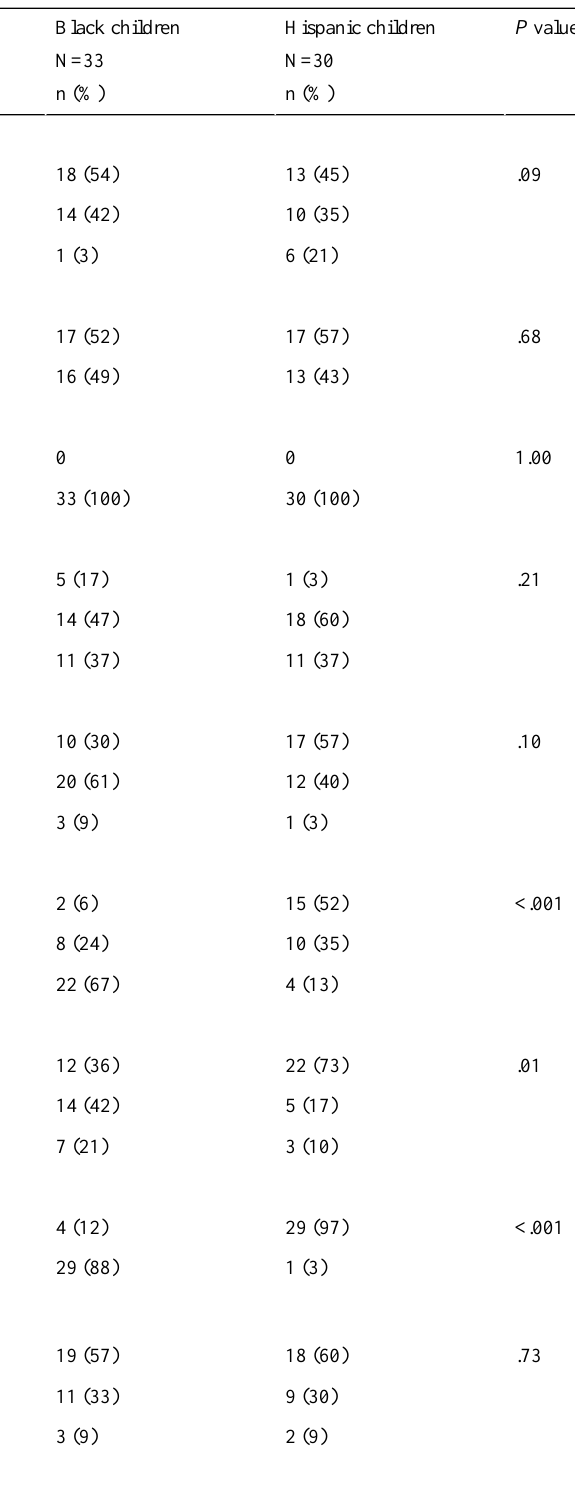
Table 1. Sample characteristics from the Children Eating Well smartphone app prototype study (note: some column percentages do not add up to 100% due to